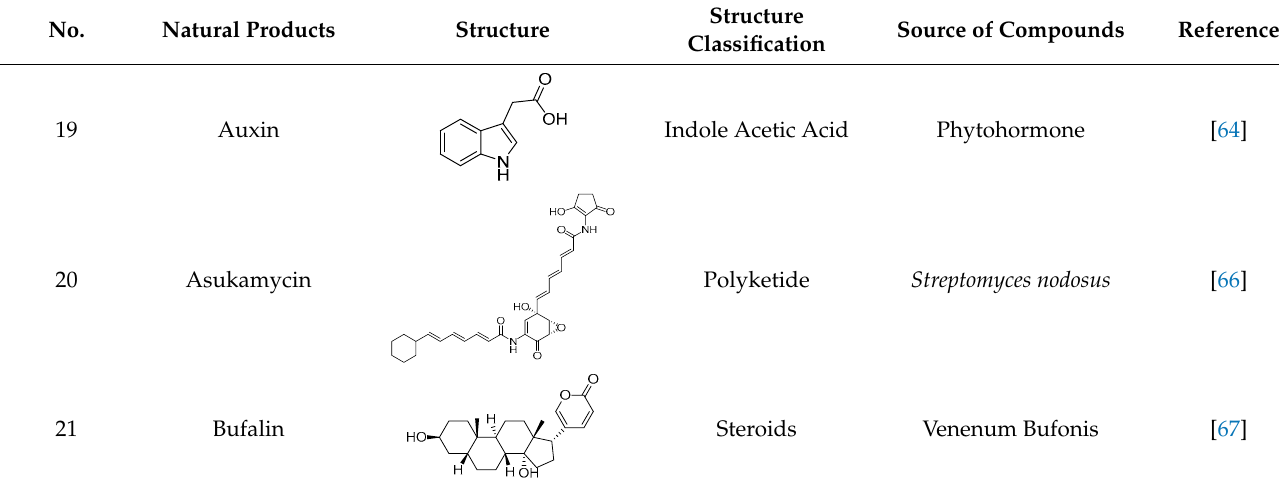
Table 11. Natural products 19–21.